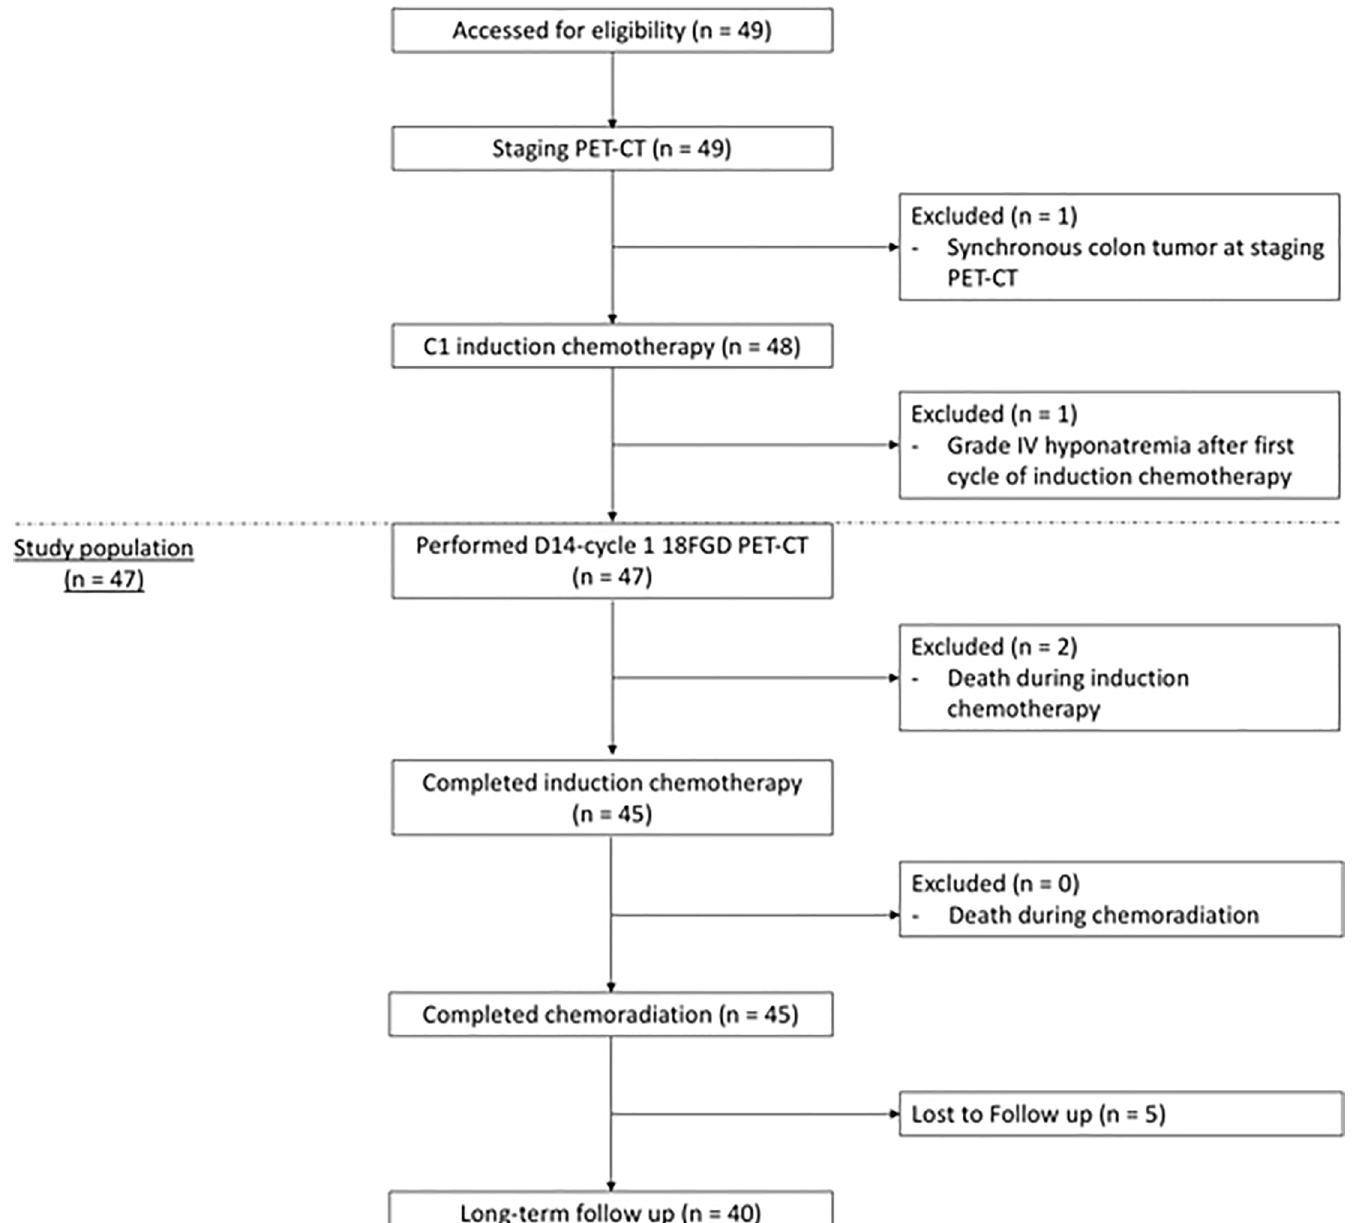
Fig 1. The Consort flowchart descriptions of the entire study